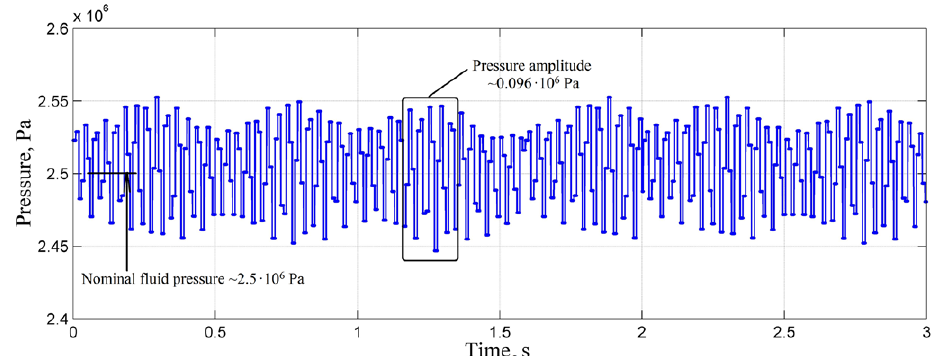
Figure 5. The fluid pressure inside high-pressure